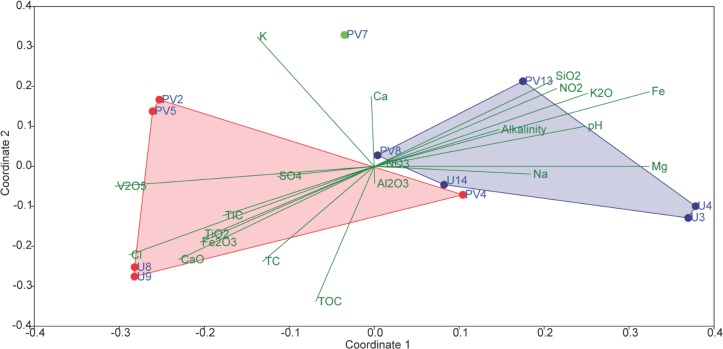
Non-metric multidimensional scaling (NMDS) analyses of microbial communities and its association with environmental factors of subsurface rock cores of Koyna–Warna region (Bray–Curtis, Stress = 0.12). Red symbols represent basaltic samples; green symbol represents transition zone samples; blue symbols represent granitic samples.